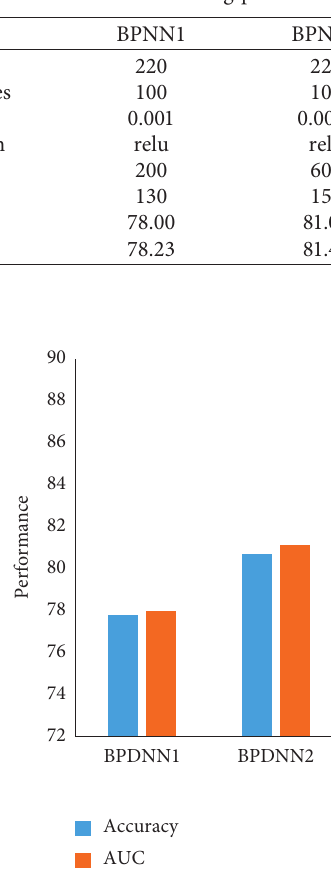
Figure 2: BPDNN flowchart. Table 2: Training parameters of the backward propagation deep neural network.